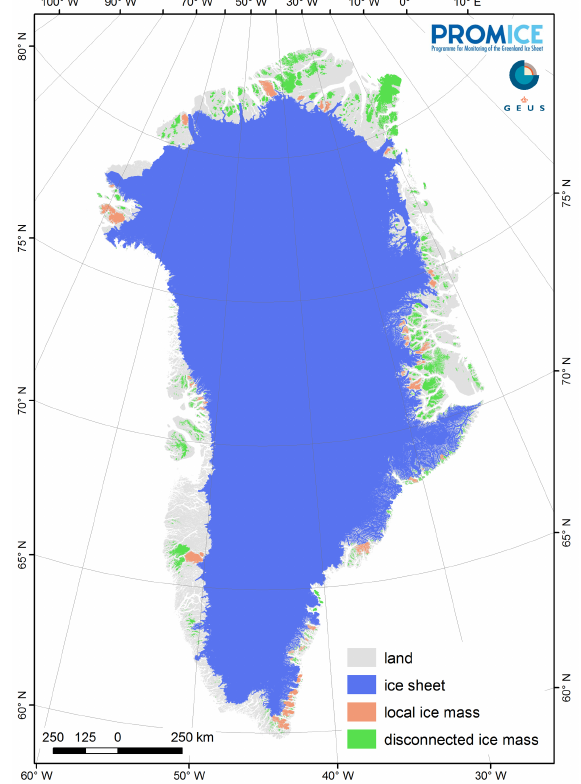
Fig. 1. Small-scale overview showing the margins of all ice masses in the PROMICE map, colour coded according to the data sources used to produce it (DPW: GEUS, digital workstation; PG2 GEUS, analogue stereoplotter, GGU: Geological Survey of Greenland, ana- logue stereoplotter, KMS: National Survey and Cadastre). The ac- tual year and geographic coverage of each flight campaigns is shown. Especially in the north-west, and occasionally in other re- gions, vectors identified as “KMS” are based on aerial photographs older than 1978–1987 (see text for details).